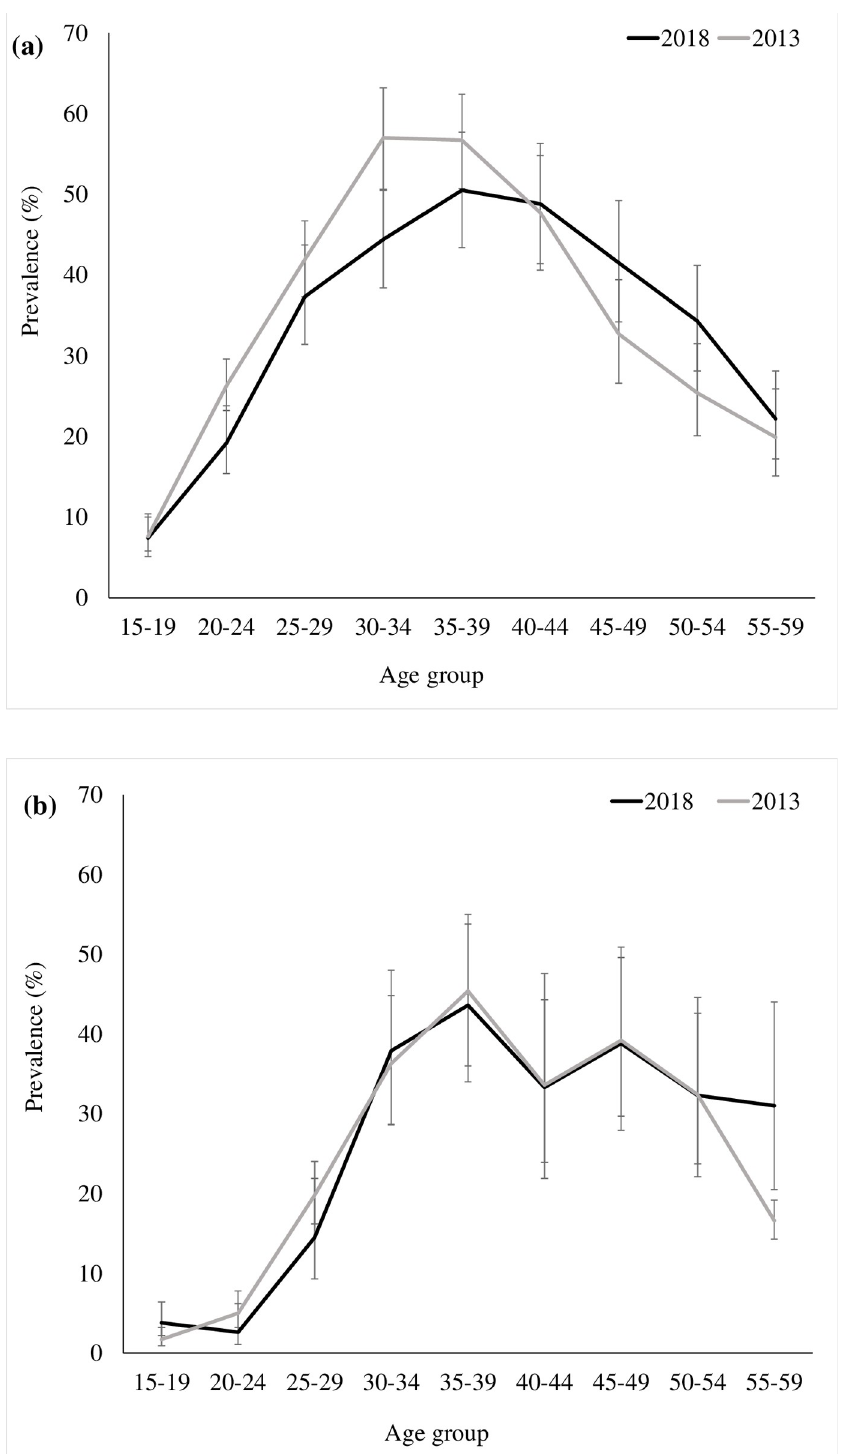
Fig 1. HIV prevalence by five-year age group among women (a) and among men (b), KwaZulu Natal, South Africa, 2013 and 2018.